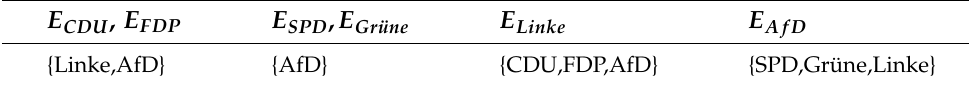
Table 3. Excluded coalition partners—German federal parliament.